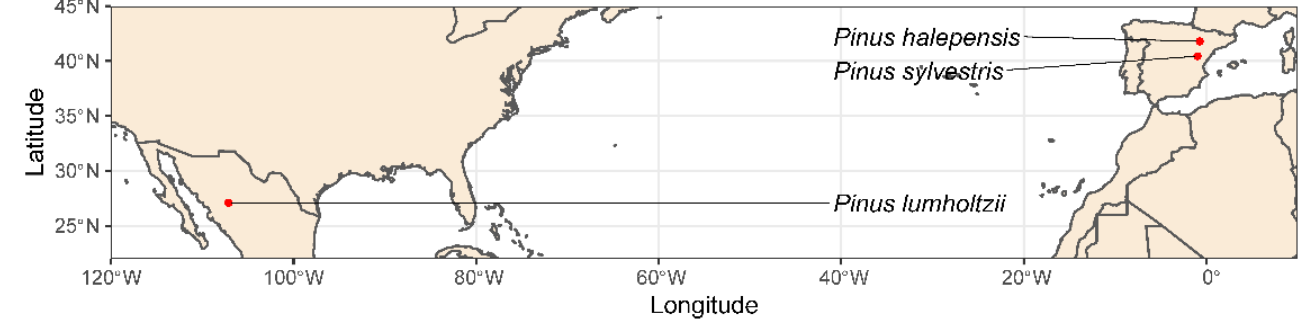
Figure 1. Map of the three study sites situated in northern Mexico and north-eastern Spain.